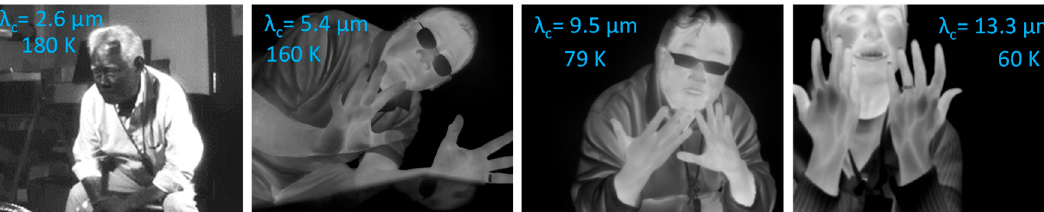
Figure 1. Images from extended-SWIR ( λ c = 2.6 µ m), MWIR ( λ c = 5.4 µ m), LWIR ( λ c = 9.5 µ m), and VLWIR ( λ c = 13.3 µ m) FPAs made from antimonide bulk and T2SL unipolar barrier infrared detectors.